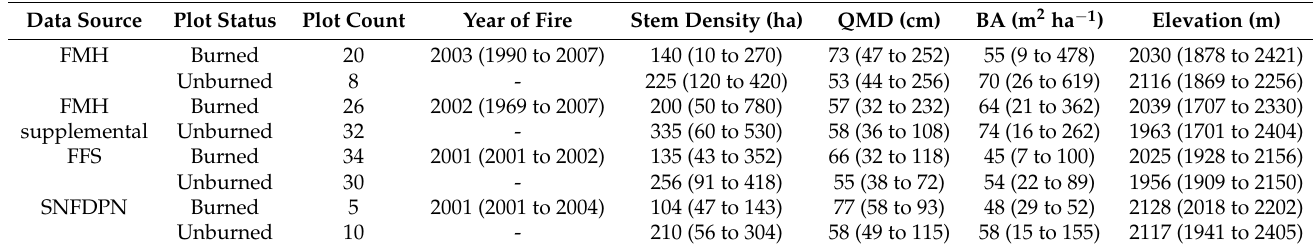
Table 1. Summary statistics of burned and unburned plots for stems >12.5 cm stem diameter at breast height (dbh), showing the median and range for year of fire (for burned plots), stem density, quadratic mean diameter (QMD), basal area (BA), and plot